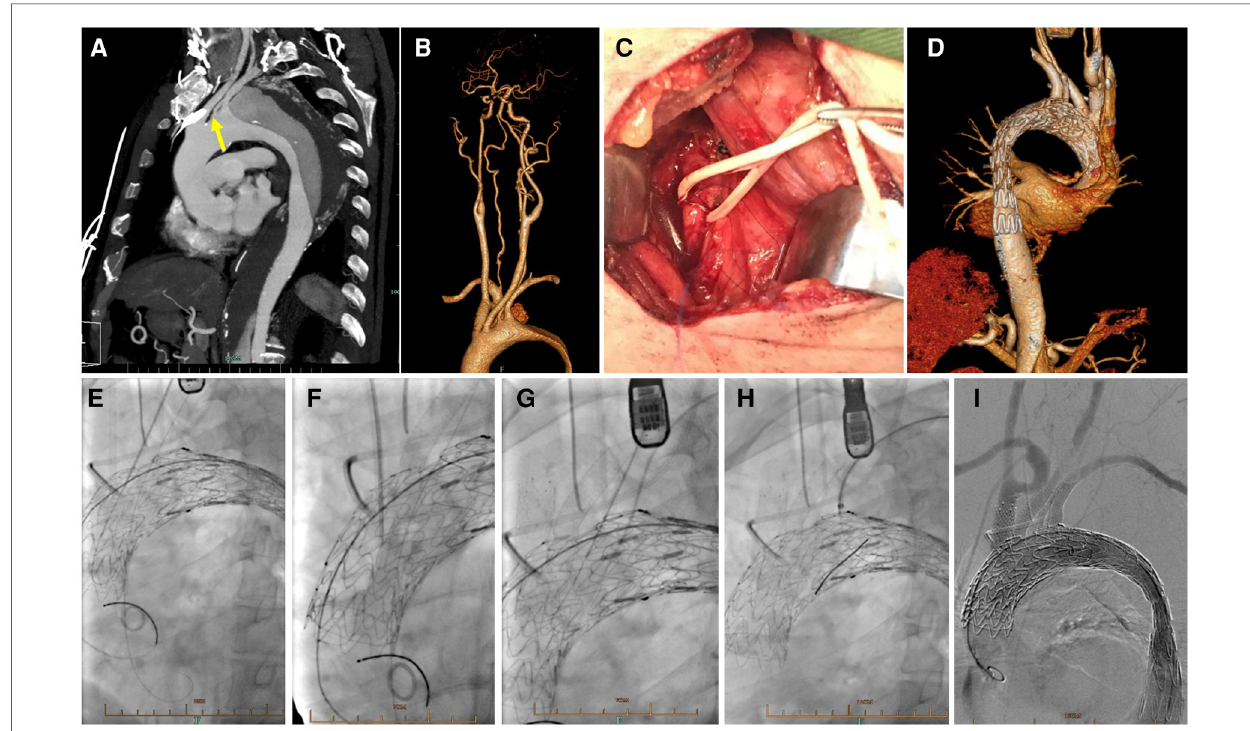
FIGURE 3 In situ fenestration for isolated left vertebral artery. ( A ) Preoperative CTA showed a type B aortic dissection with ILVA (yellow arrow); ( B ) The cervicle contrast-enhanced CTA demonstrated dominant ILVA and incomplete circle of Willis; ( C ) During procedure, the ILVA was exposed with a supraclavicular incision; ( D ) Follow up CTA showed well exclusion of aortic dissection and patent supra aortic branches; Needle-assisted in situ fenestration followed by bridging stents placement for reconstruction of LCCA ( E ), BCT ( F ), ILVA ( G ) and LSA ( H ) after deployment of stent graft; ( I ) Complete aortography demonstrated excluded aortic dissection and patent branch